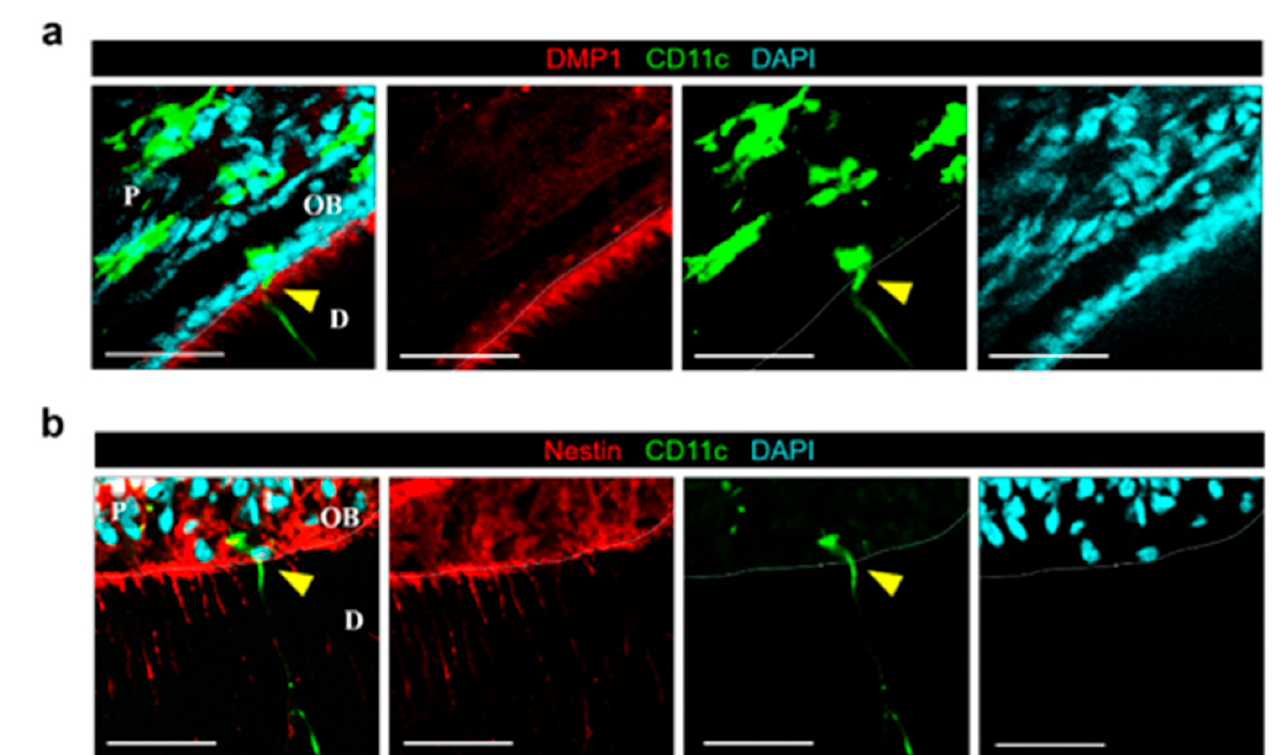
Figure 2. CD11c+ cell at dentin-pulp interface does not express odontoblast differentiation markers of DMP1 and Nestin. ( a ) Single-plane images of the tooth extracted from CD11c-YFP mouse after immunostaining of DMP1. Yellow arrowhead marks CD11c+ cell at the dentin-pulp interface. Scale bar, 50 µ m. DMP1 (red), CD11c (green), DAPI (cyan). ( b ) Single plane images of the tooth extracted from CD11c-YFP mouse after immunostaining of Nestin. Yellow arrowhead marks CD11c+ cell at the dentin-pulp interface. Scale bar, 50 µ m. Nestin (red), CD11c (green), DAPI (cyan). White dotted lines delineate the dentin-pulp interface. D : dentin, P : pulp, OB : odontoblast layer.